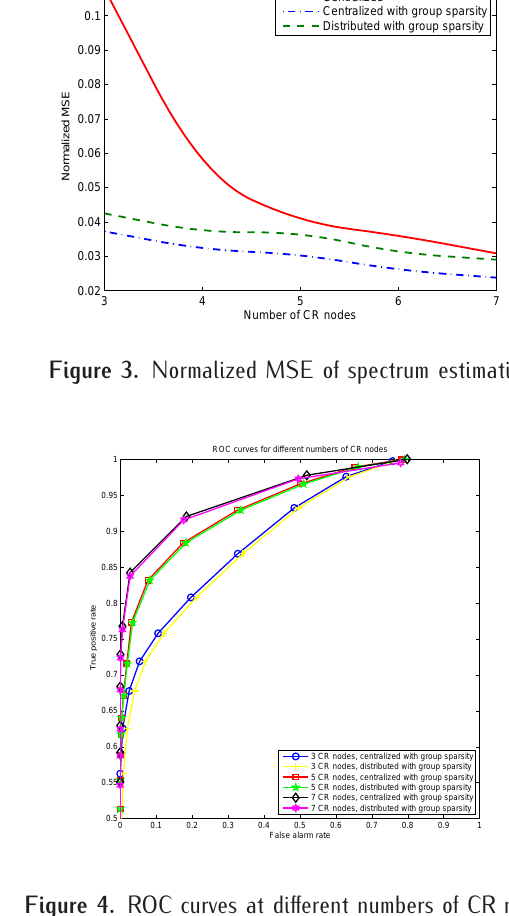
Figure 4. ROC curves at different numbers of CR